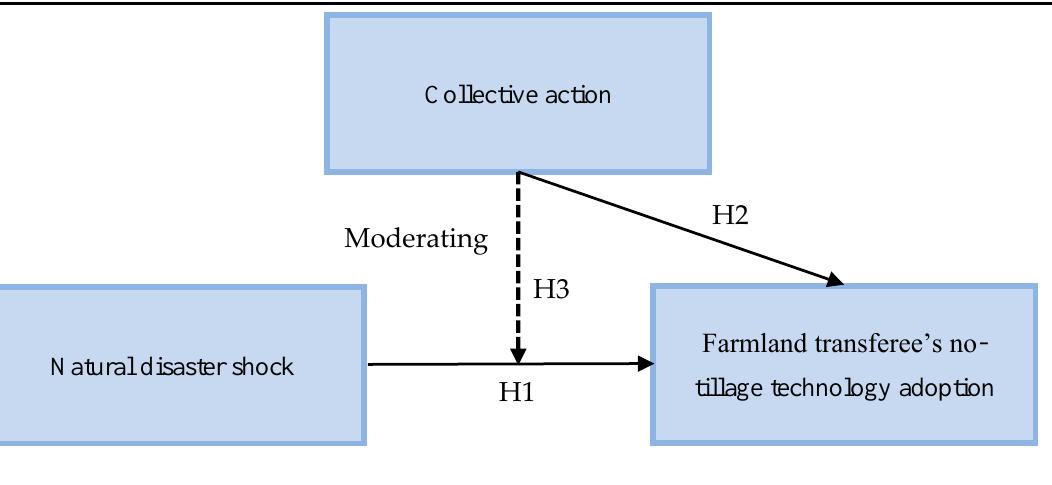
Figure 1. The theoretical framework used in the current study.